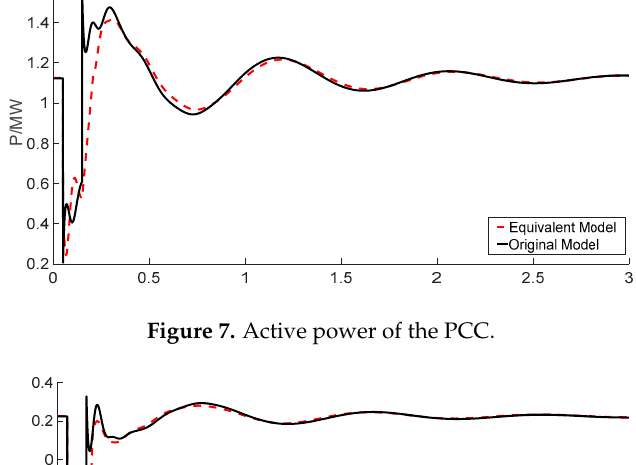
Figure 7. Active power of the PCC.